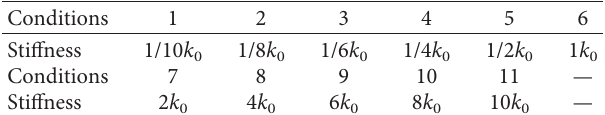
Figure 18: The maximum dynamic coefficient deviation rate of the bridge under the moving load model after the coefficient correction. Table 5: Working conditions of the primary spring stiffness of the vehicle.